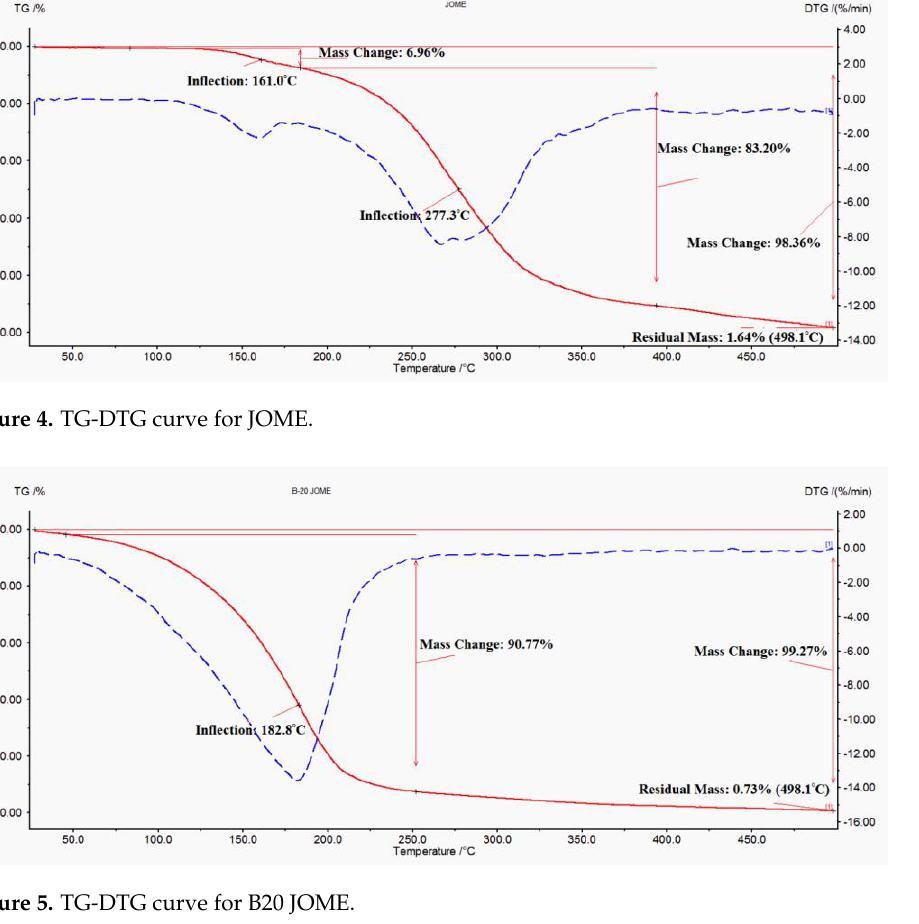
Figure 3. TG-DTG curve for diesel.